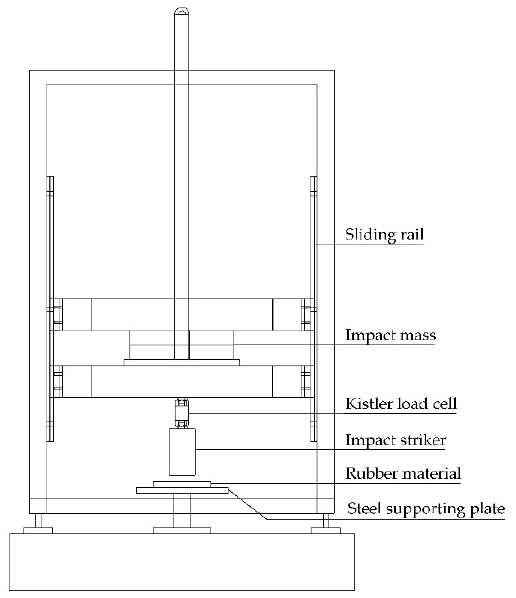
Figure 1. Illustration of the custom-built drop-testing machine used to measure impact energy.